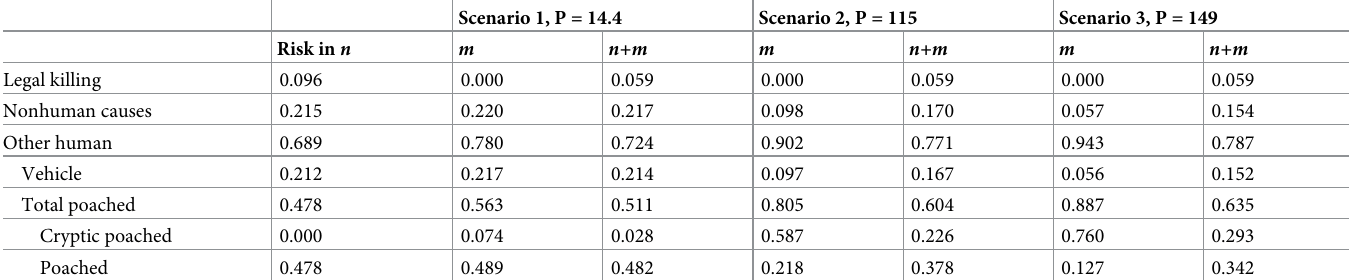
Table 4. Risk of legal, nonhuman and other human causes of death for known fates ( n ) and the unknown subset ( m ) using 3 cryptic poaching scenarios (P from Eqs 1A–1C). Total poached is the sum of poached and cryptic poached. Other human is the sum of Vehicle and Total Poached (Table 4 in S1 File).